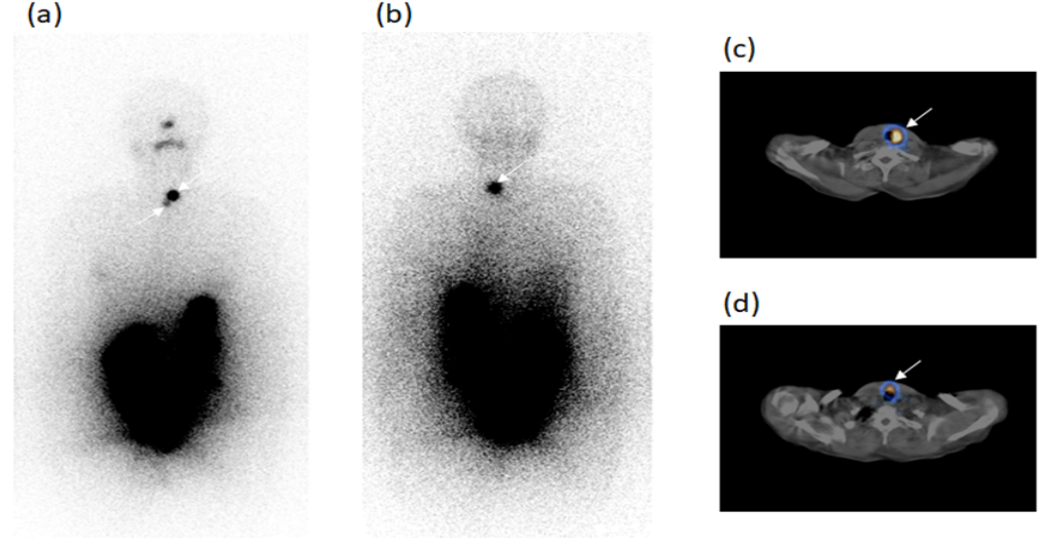
Figure 4. A 60-y-old female patient (case n. 13, Table 4) submitted to total thyroidectomy for multifocal-bilateral papillary carcinoma, tumor diameter 15 mm, at the first radioiodine ablation. 131 I-WBS after therapeutic radioiodine dose, in both anterior ( a ) and posterior ( b ) views evidenced two radioiodine-avid foci of different activity in the median region of the neck classified as tissue residues. Fused SPECT/CT images in transaxial slides ( c , d ) also identified the two foci evidenced by WBS confirming residual origin. Both WBS and SPECT/CT excluded the presence of foci doubtful of malignant lesions. Thyroglobulin levels in hypothyroidism condition: 4.2 ng/mL. AbTg: absent.